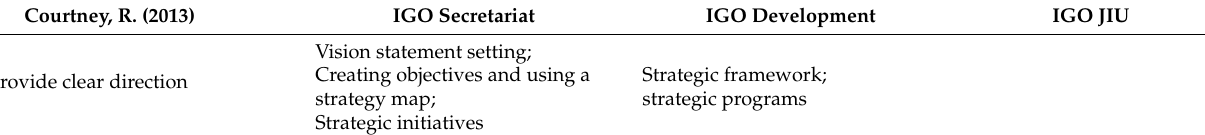
Table 1. Strategic planning process: Mapping between good strategy criteria and IGO processes. Courtney, R.